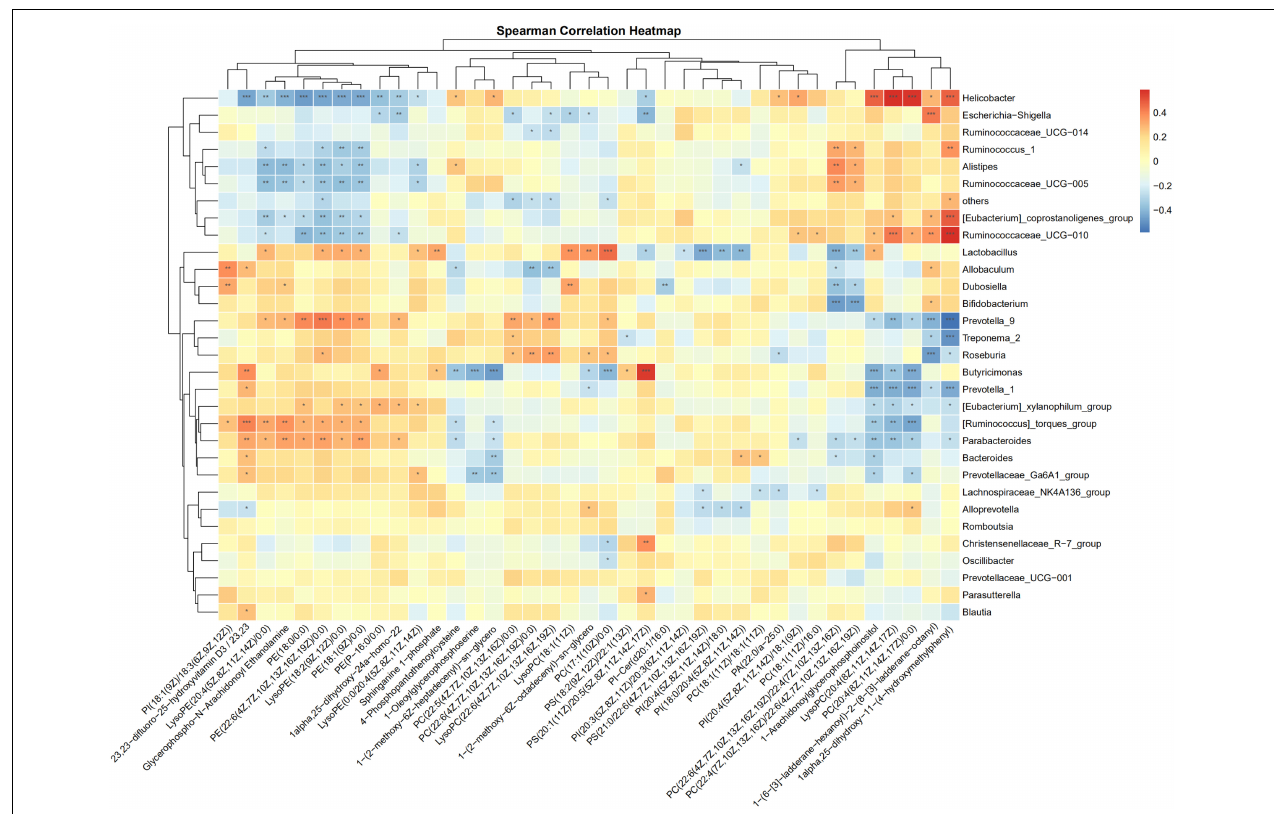
FIGURE 9 | Spearman correlation analysis heatmaps of gut microbiome and glycerolipids. *, **, *** represents a significant difference, * p < 0.05, ** p < 0.01, *** p < 0.001 as determined by t